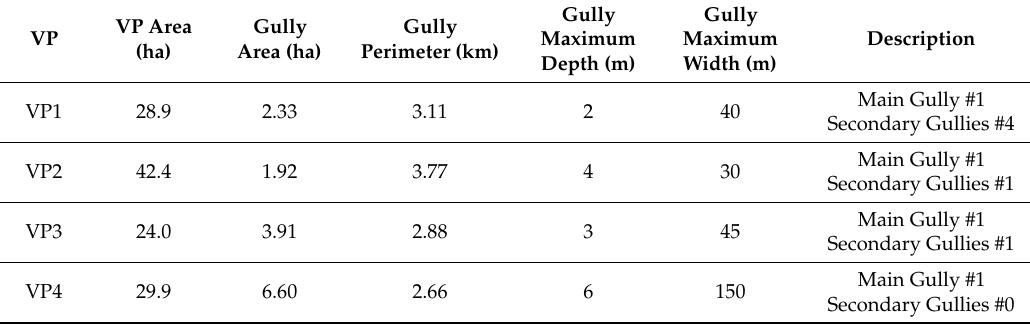
Table 2. Summary description of the four Validation Plots (VPs) selected from Krumhuk